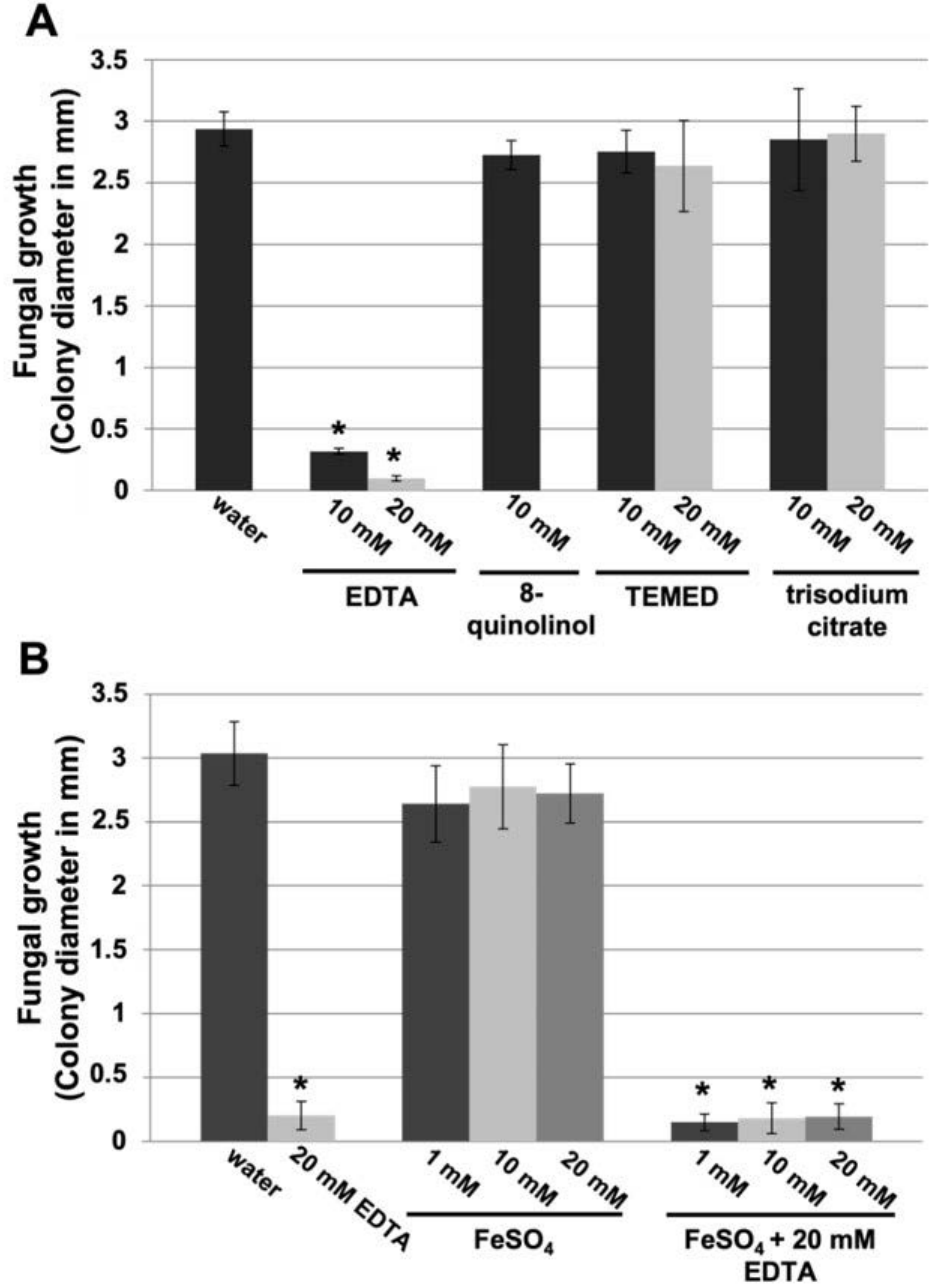
Figure 4. Nondisease-suppressing effect of other chelating agents and disease-suppressing effect of EDTA in presence of metal ions against cucurbit powdery mildew. Melon cotyledon discs were exposed to the different treatments and inoculated with P. xanthii as described in the Materials and Methods. Powdery mildew symptoms expressed as the P. xanthii colony diameter (in mm) were recorded 12 d after pathogen inoculation. ( A ) Effect of the chelating agents EDTA, 8-quinolinol, TEMED (tetramethylethylenediamine), and trisodium citrate on powdery mildew. ( B ) Effect of ferrous ions (FeSO 4 ) on EDTA disease suppression. EDTA was combined with different concentra- tions of FeSO 4 . Data represent the means of ten samples from two independent experiments, with error bars representing the standard error. The asterisks indicate a statistically significant difference between the treatment and the negative control (water) according to an LSD test ( p = 0.05). See Figure S2 for representative pictures. Data for 20 mM 8-quinolinol are not shown, because it is phytotoxic at this